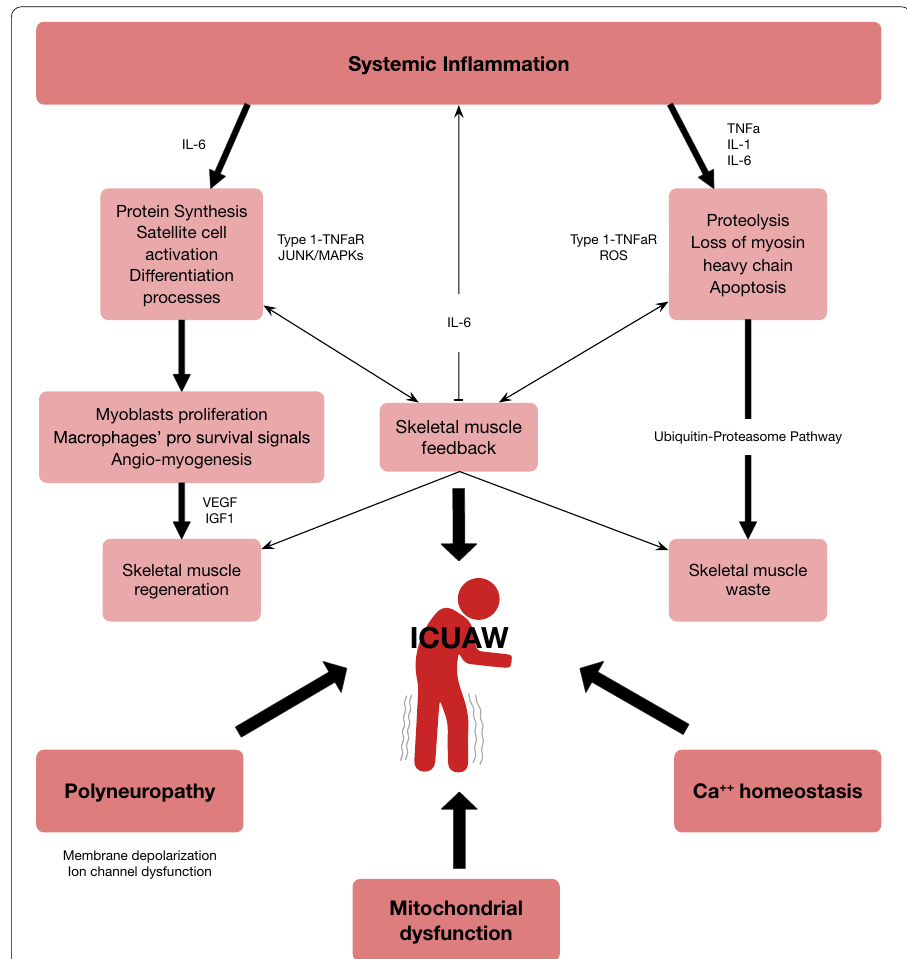
Fig. 4 Mechanisms of ICU‑acquired weakness. Systemic inflammation, polyneuropathy and local impairment of mitochondria and calcium influx result in a disbalance between protein synthesis and degradation, leading to muscle